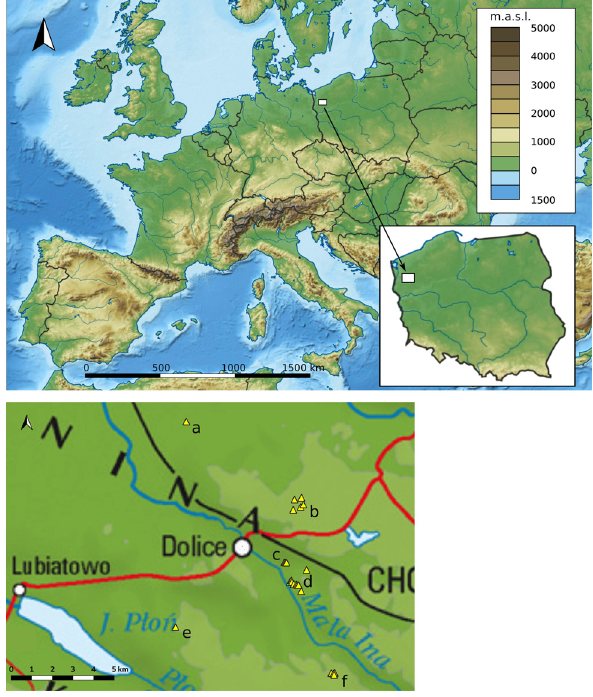
Figure 1: Location of the Pyrzyce Lowland and the analysed megalithic tombs (( a ) Kr ę pcewo, ( b ) Dolice - Rondo Lucjana, ( c ) Dolice - Komorowo North, ( d ) Dolice – Komorowo South, ( e ) Karsko, and ( f ) P ł oszkowo ( M. Schiller ))